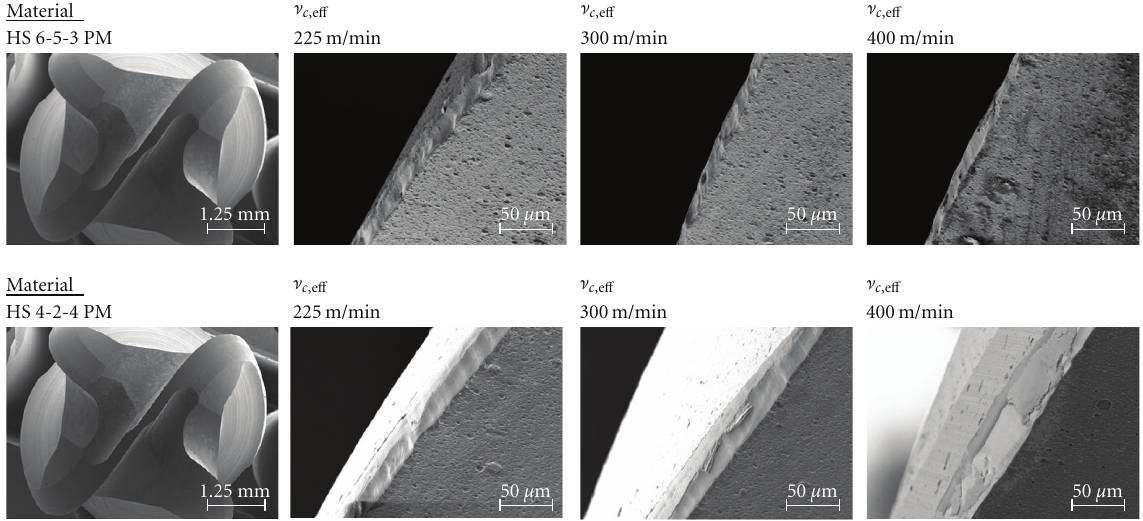
Figure 12: Tool wear qualification.